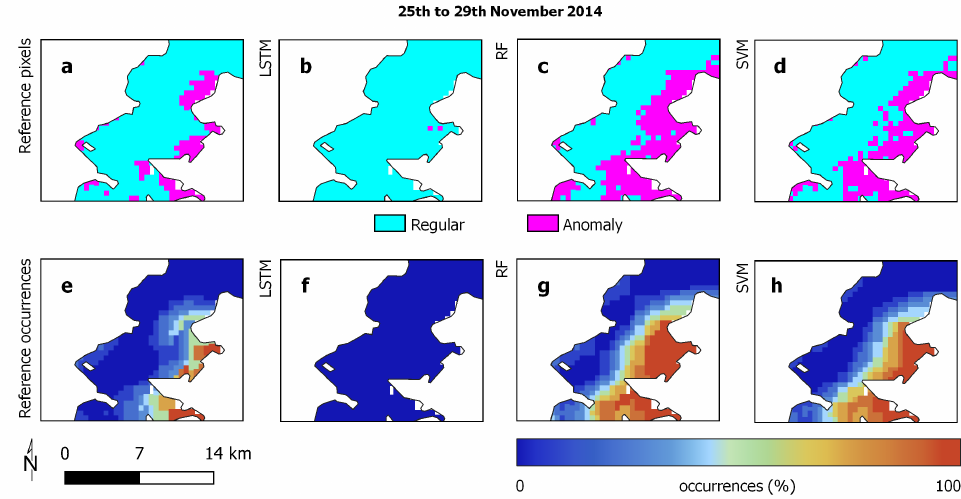
Figure 14. Period trend forecasting based on pixels ( a – d ) and occurrences ( e – h ) from 25–29 November 2014, related to Lake Chilika. Plots ( a , b ) represent the mapping of the reference